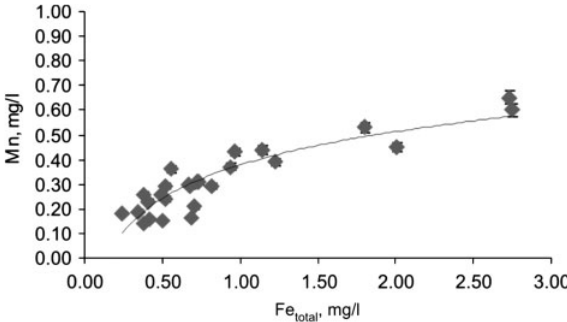
Fig. 6. Dependency between total iron and manganese concentrations in Vilnius network sampling points